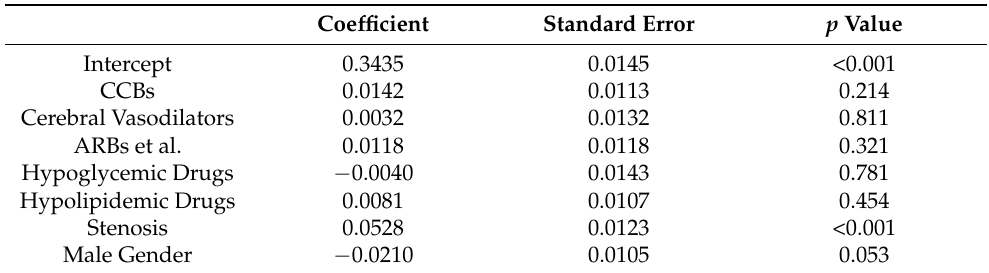
Table 6. Relations between the maximum First Harmonic Ratio and medications (N = 50).